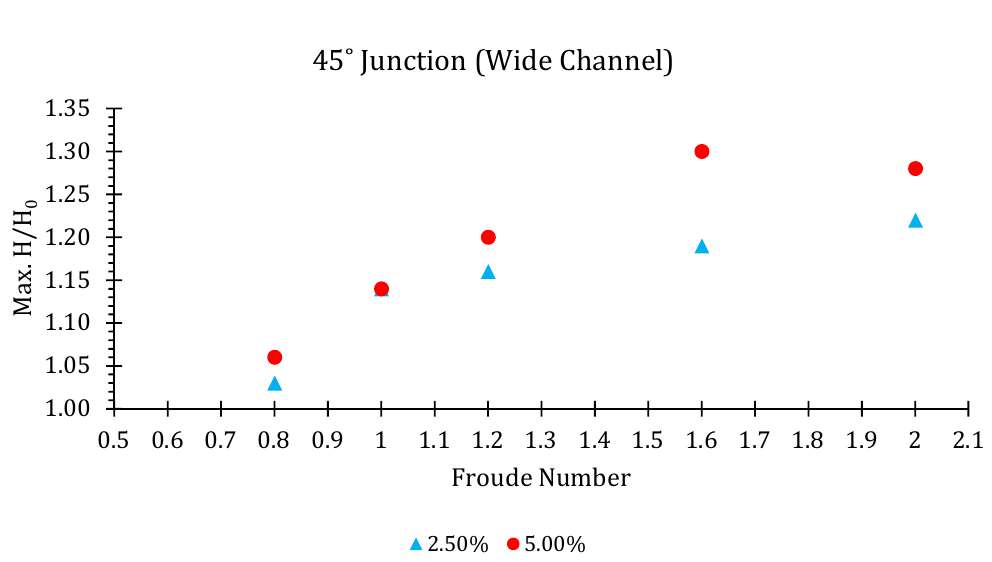
Figure 12. Maximum water height ratios in a 45° junction (wide channel).